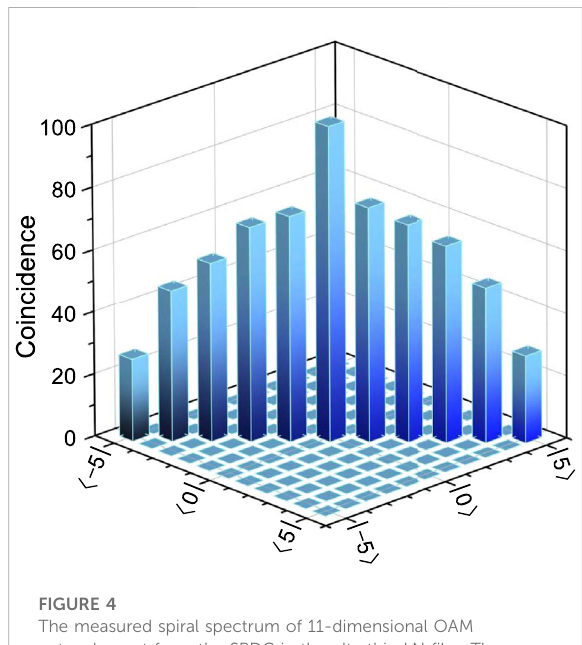
FIGURE 4 The measured spiral spectrum of 11-dimensional OAM entanglement from the SPDC in the ultrathin LN fi lm. The coincidence time is 1 s